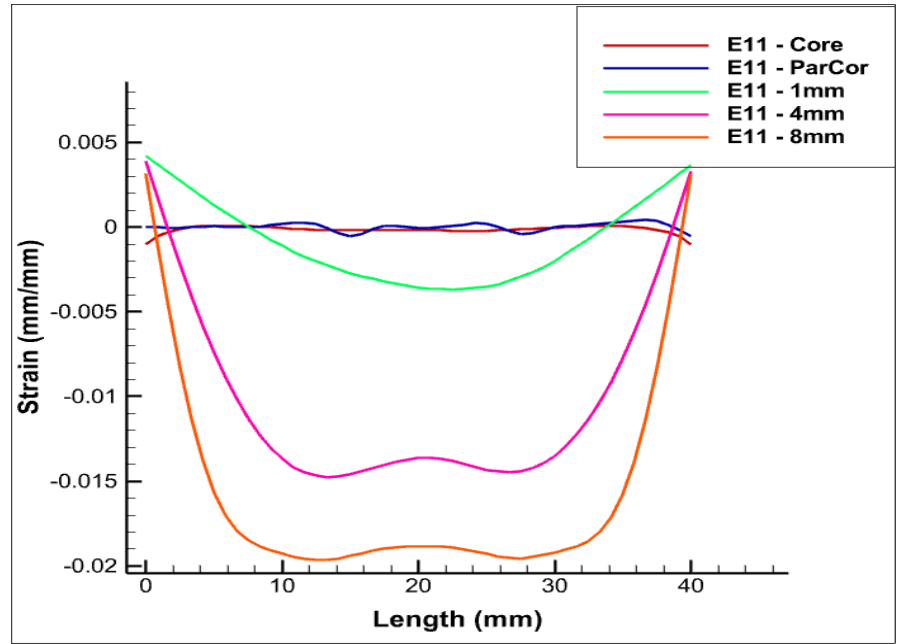
Figure 6. Exx for various positionings of FOS in the case of the pure bending test case, along x axis. A slight offset is pictured in the above Figures 6–8 that corresponds to the linear-placed FOS, located at 1 mm within the insulator (in green). The boundary condition applied explains the extreme strain values shown at half a length of the phase. The constraints on both sides of the cables produce strain values around zero. As explained above, the placement of FOS was considered further within the insulator (4 mm, in pink). The